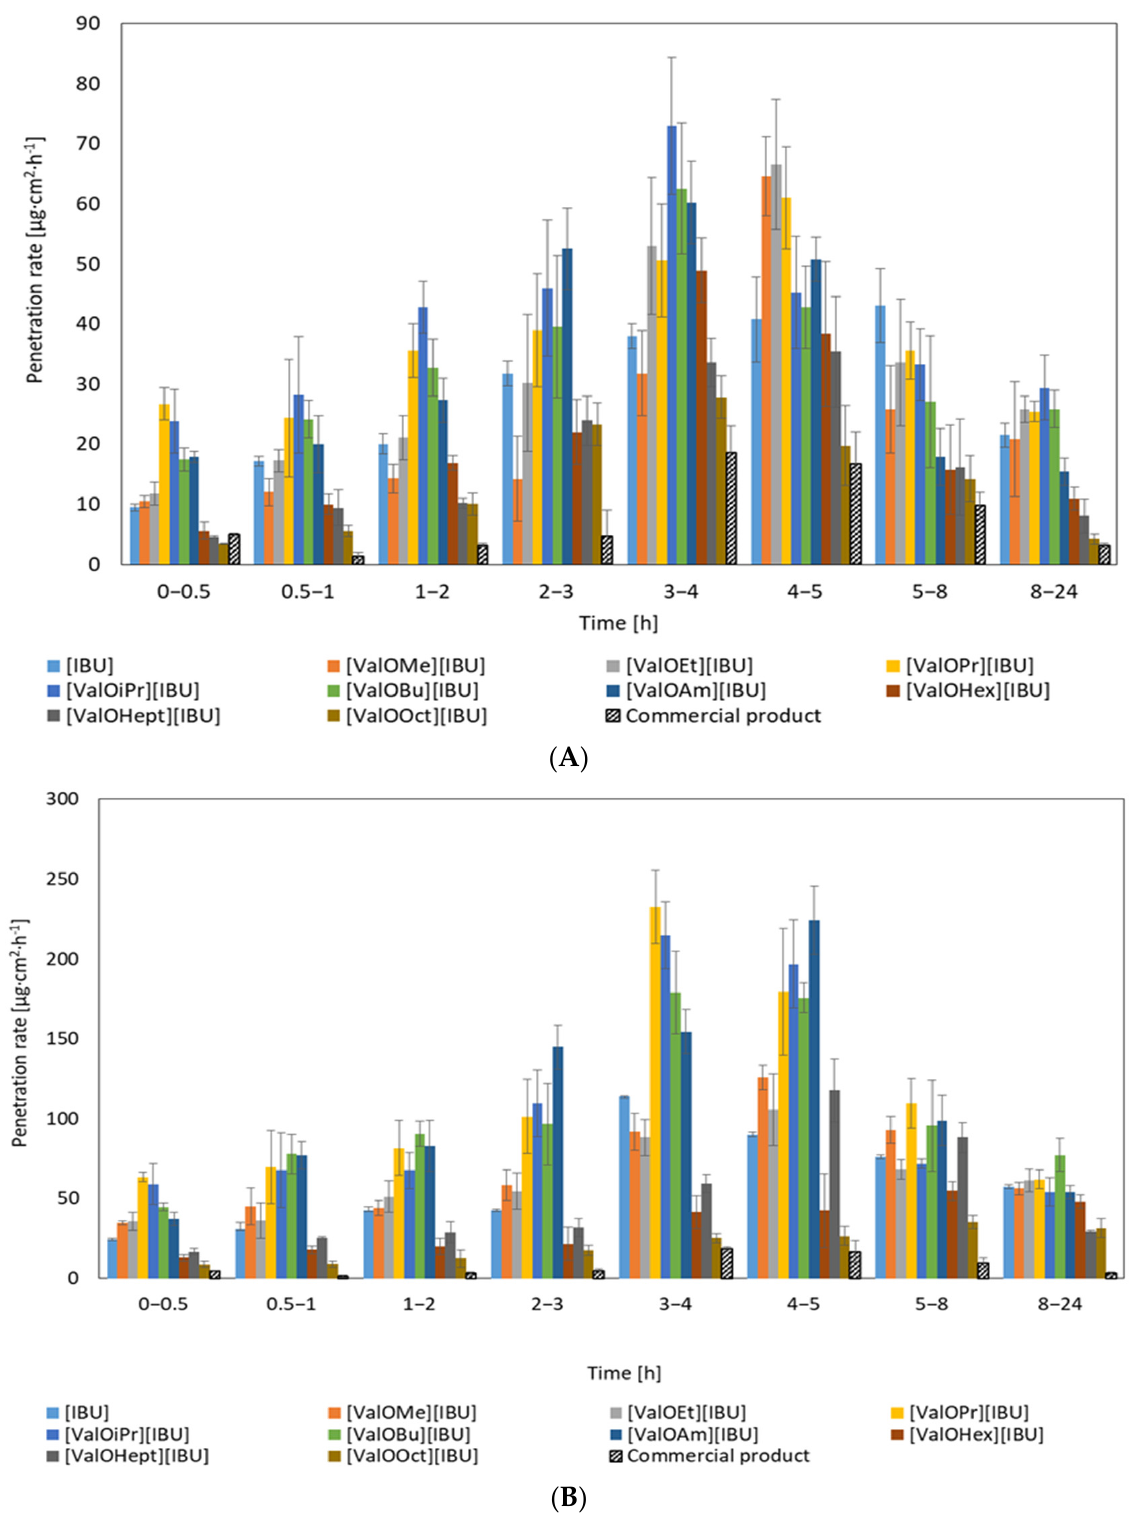
Figure 5. Ibuprofen’s penetration rate and derivatives permeated through human skin ( A ) and transdermal diffusion test model ( B ). Each point represents the mean ± SD ( n = 3).